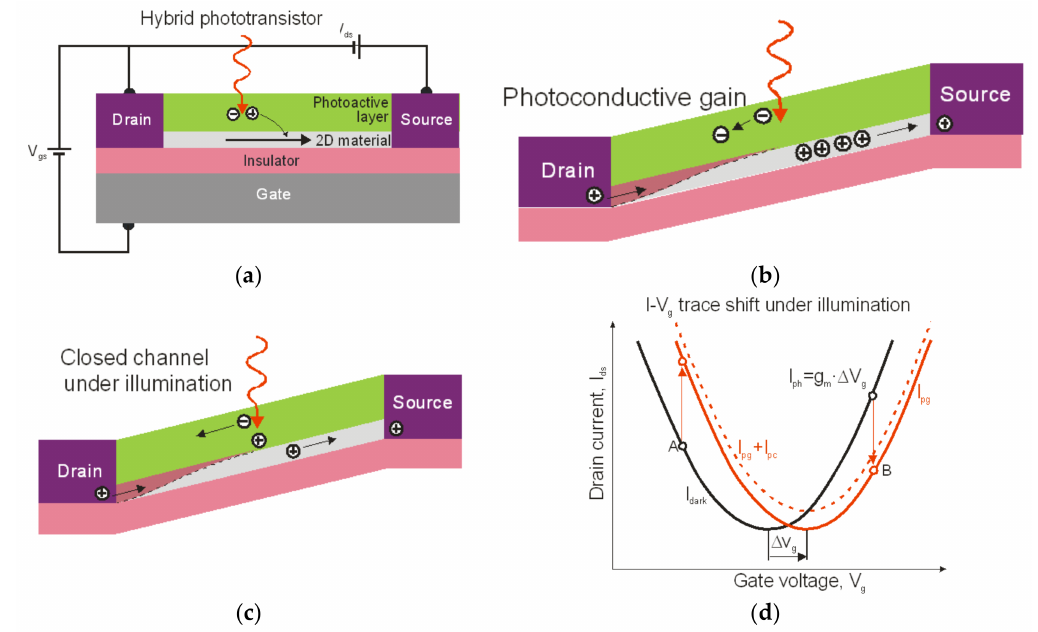
Figure 14. Photogating effect in 2D material photodetectors: ( a ) the operation of hybrid phototransistor, ( b ) closed channel under illumination, ( c ) photoconductive gain, and ( d ) I-V g trace under